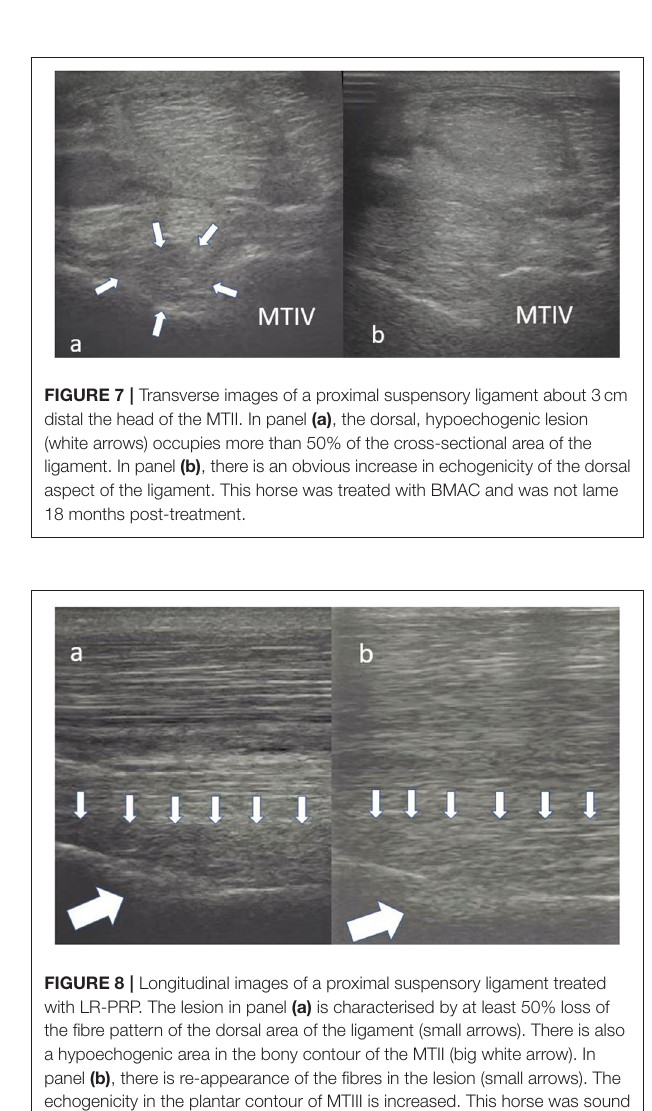
higher level than pre-injury ( n = 14) and those which were lame ( n = 8).